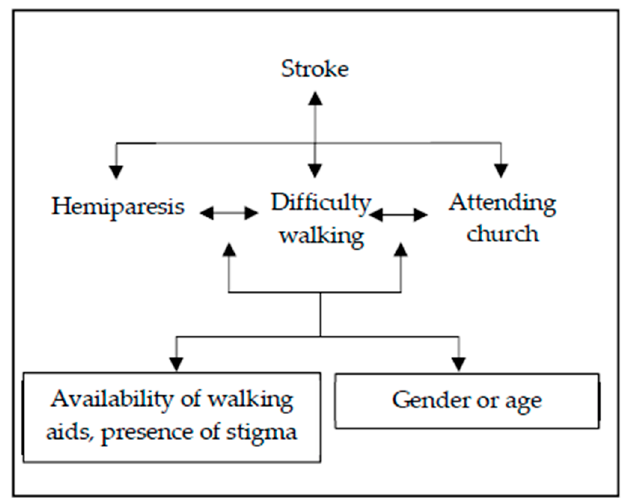
Figure 2. World Health Organisation International Classification of Functioning: a case study of stroke.